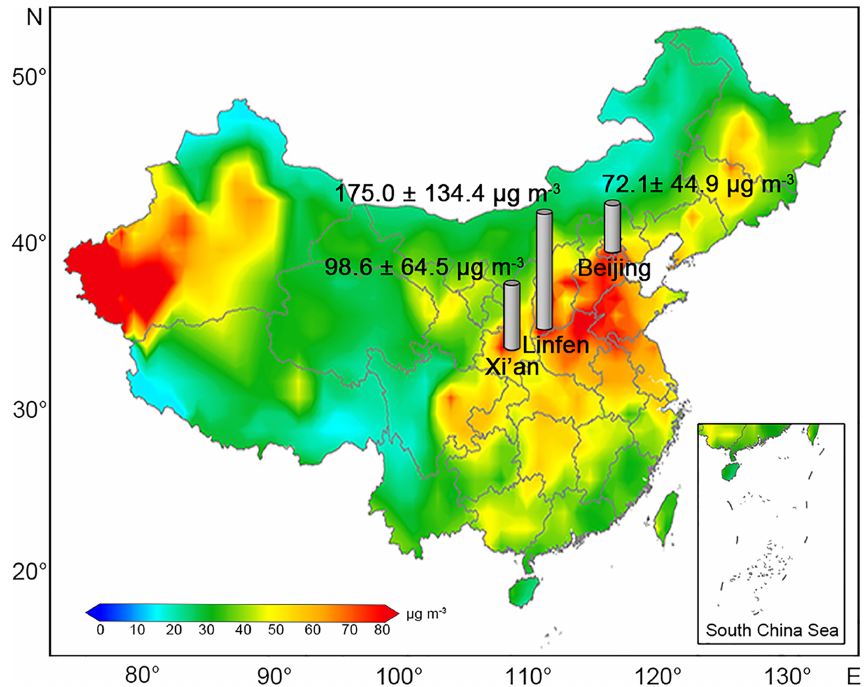
Figure 1. Locations and PM 2 . 5 concentration of Beijing (BJ), Xi’an (XA), and Linfen (LF). The background map shows the distribution of PM 2 . 5 concentrations in most of China from 2015 to 2019 (H. M. Li et al., 2021). The gray bars are the average PM 2 . 5 concentrations of the samples collected in this study during 2018 to